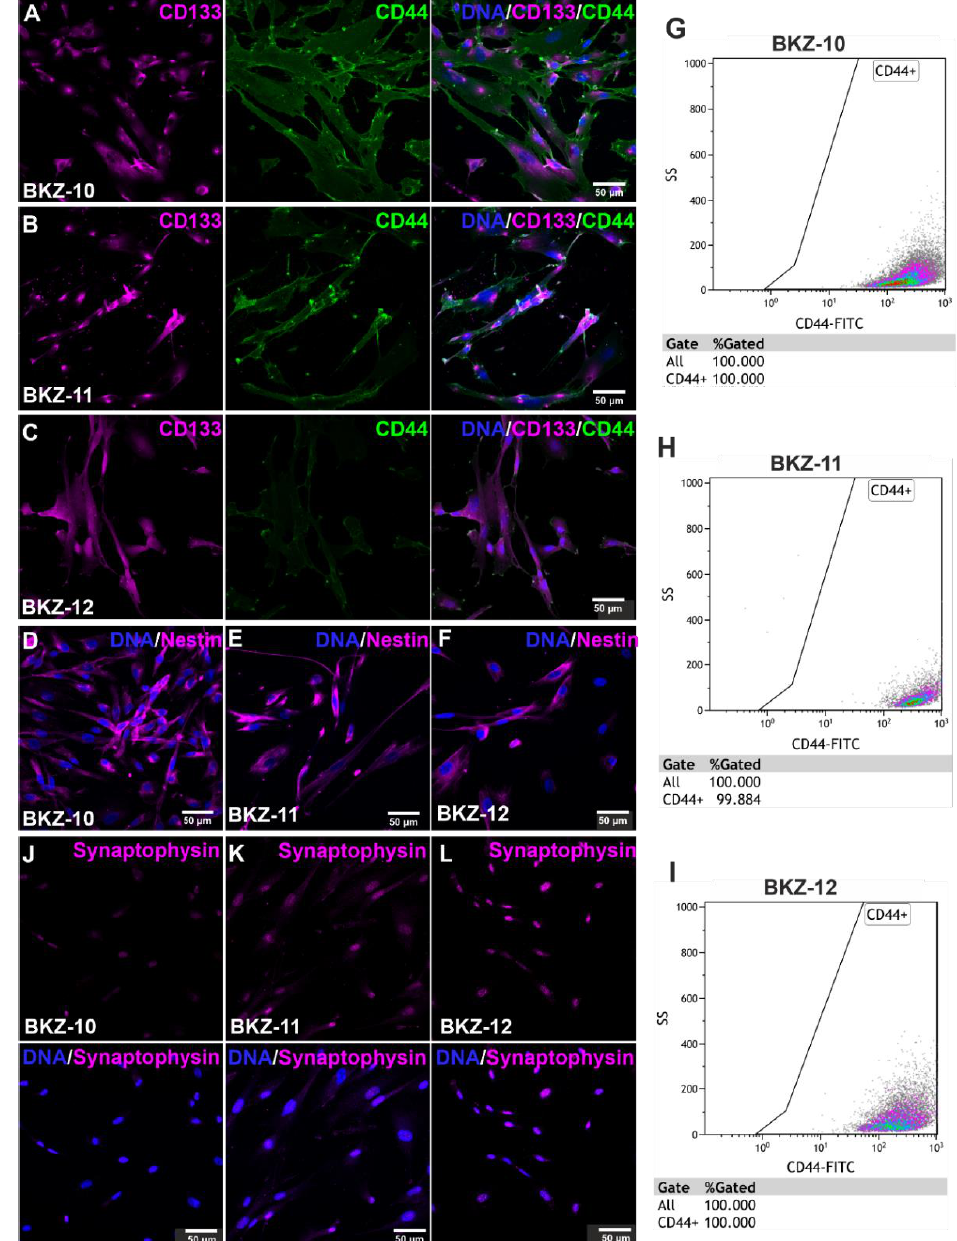
Figure 2. Isolated endometrial carcinoma-derived stem-like cell populations express cancer stem cell markers. Immunocytochemical staining revealed a high amount of cancer stem cell markers ( A – C ) Prominin-1 (CD133), CD44 antigen (CD44) and ( D – F ) Nestin. Flow cytometric analysis of CD44-positive cells depicted 100% positive cells for ( G ) BKZ-10 as well as for ( I ) BKZ-12 and 99.884% CD44-positive cells for ( H ) BKZ-11. Immunocytochemical analysis demonstrated the nuclear expression of synaptophysin for ( J ) BKZ-10, ( K ) BKZ-11 as well as ( L ) BKZ-12. Additional analysis via flow cytometry reveals 100% CD44-positive cells for BKZ-10 2.3. Endometrial Carcinoma-Derived Stem-like Cells Show an EMT